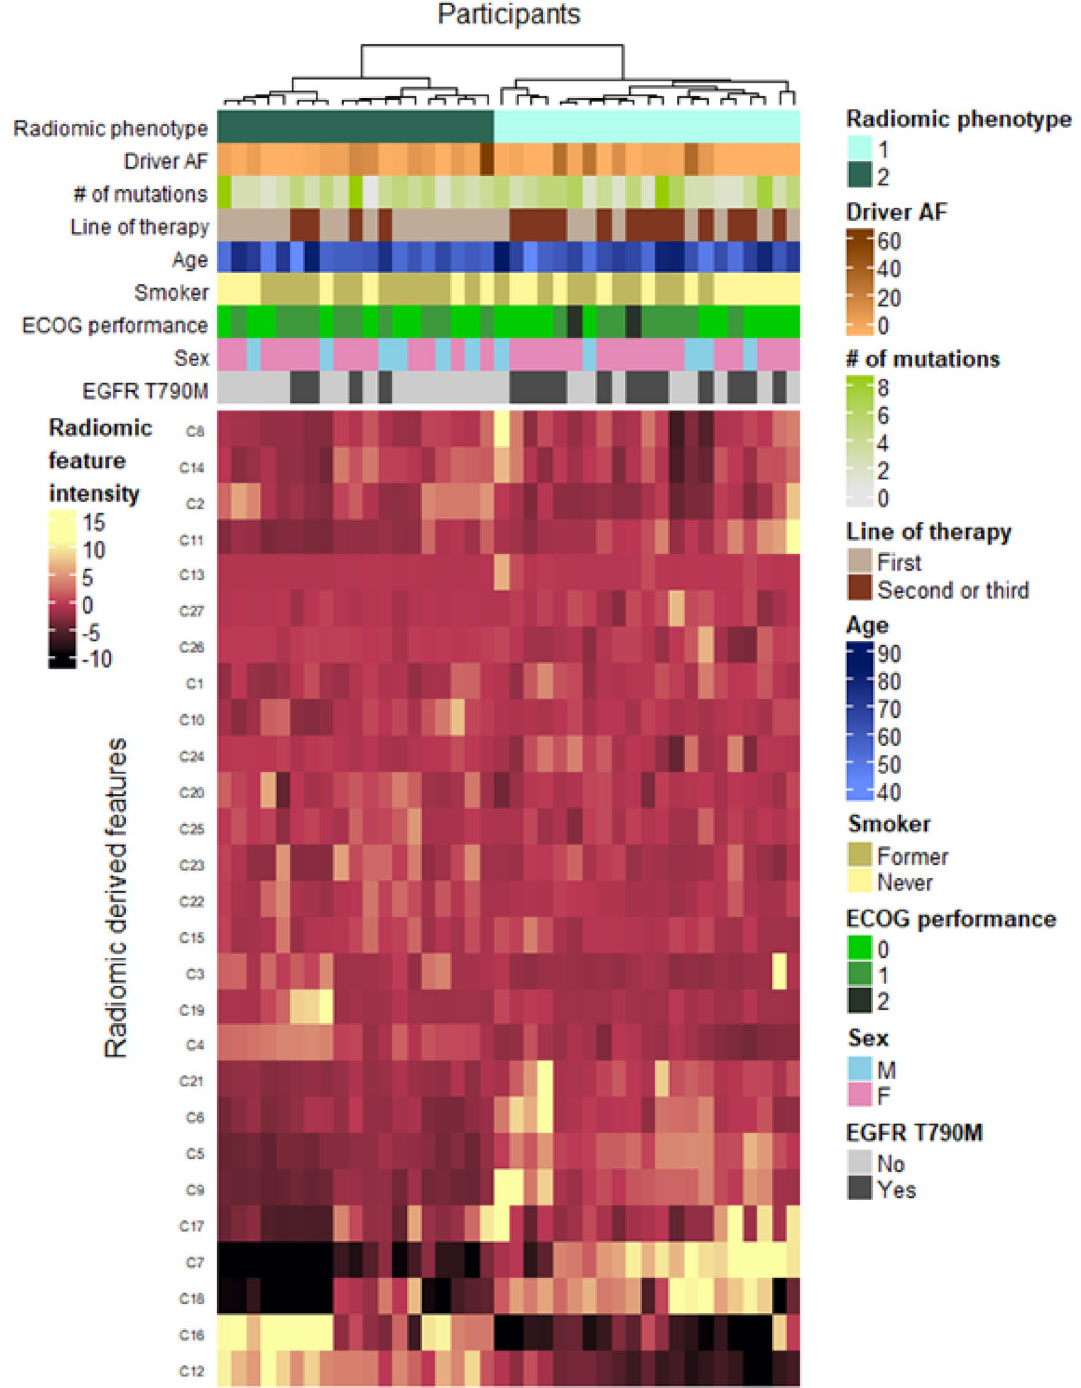
Figure 3. Heatmap of radiomic derived features. Unsupervised hierarchical clustering identifies two distinct, and statistically significant (p < 0.05), tumor radiomic phenotypes. Association of these phenotypes with study covariates is shown by the top colorbars. Driver AF is the percent allele fraction for the detected epidermal growth factor receptor ( EGFR ) driver mutation. EGFR T790M refers to those patients for whom the mutation was detected in circulating-tumor